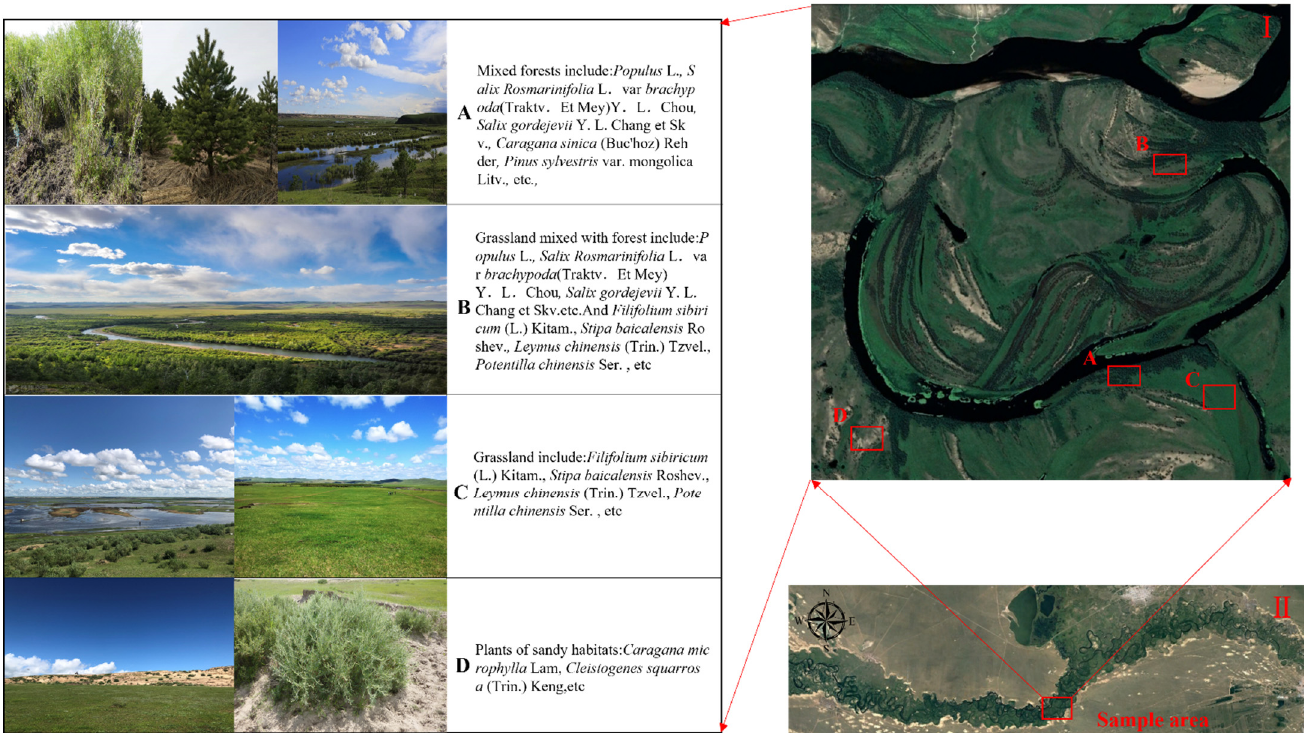
Figure 6. The description of vegetation types in the study area.(I: Is an enlarged view of a typical area in the picture II; II: It is a typical area with well-developed river floodplain wetland vegetation in the study area)